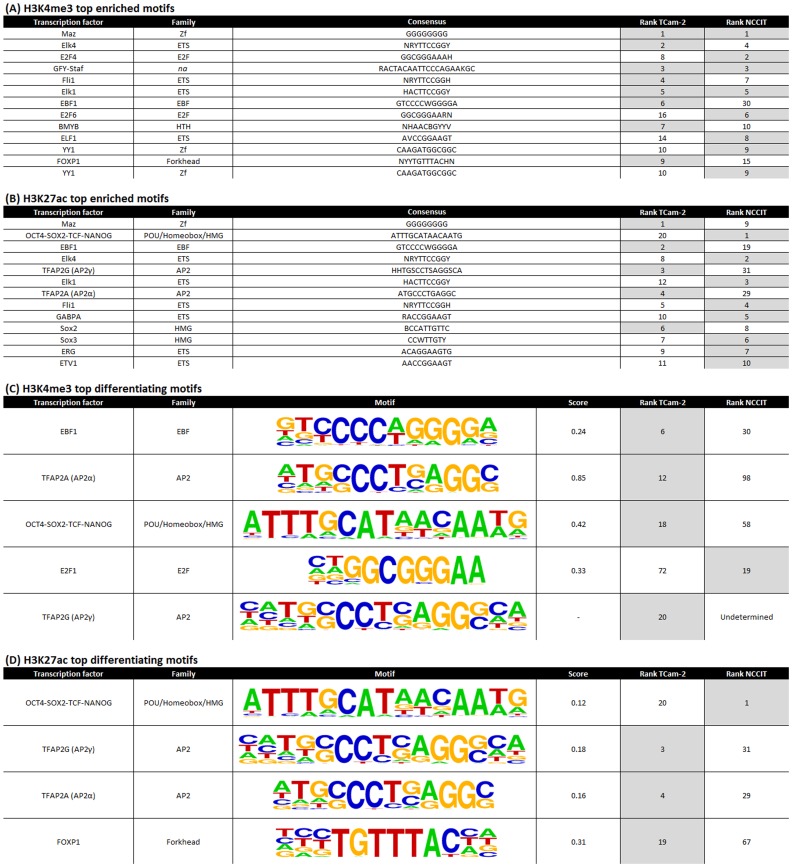
Motif enrichment in histone modification data.All motifs were significantly enriched in target over background sequences (p<0.01). Fold enrichment is indicated relative to background. (A,B) Top ranking motifs in both cell lines showed strong overlap (top 10). (C,D) Motifs that differed strongly between the cell lines with regard to their enrichments were selected. A motif was assessed favorably if its ranking was high (≤20) for one cell line and low for the other cell line (or was absent in the other list of enriched motifs). Score: The difference in ranking was assessed based on the difference in relative position in the list (|1-(rTCam-2/nTCam-2)–1-(rNCCIT/nNCCIT)|≥15%, n = nr of enriched motifs, r is the rank of a specific motif in the list of enriched motifs for either cell line).